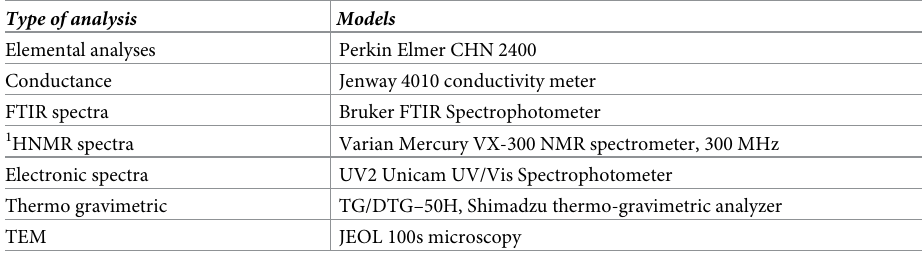
Table 1. Instrumental analysis and the corresponding